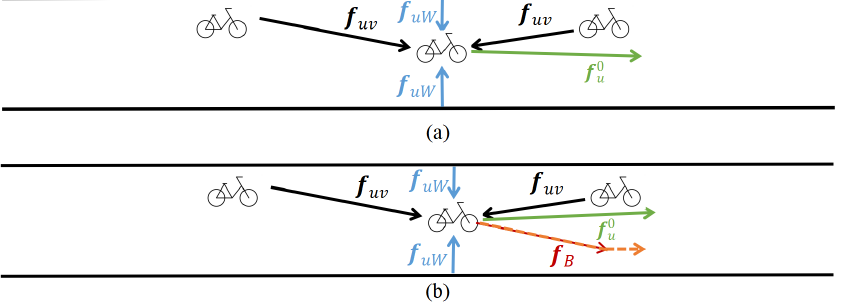
Figure 1. Comparison of the original SFM and the modified SFM. ( a ) The original SFM. ( b ) The modified